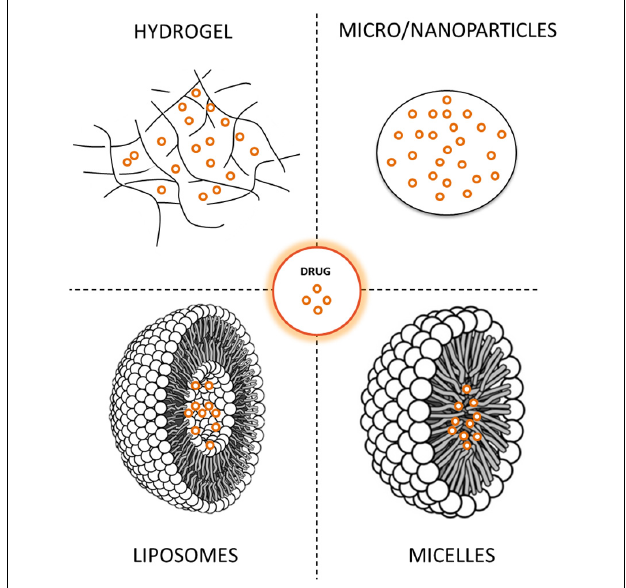
FIGURE 2 | Drug delivery systems under investigation for Parkinson’s disease